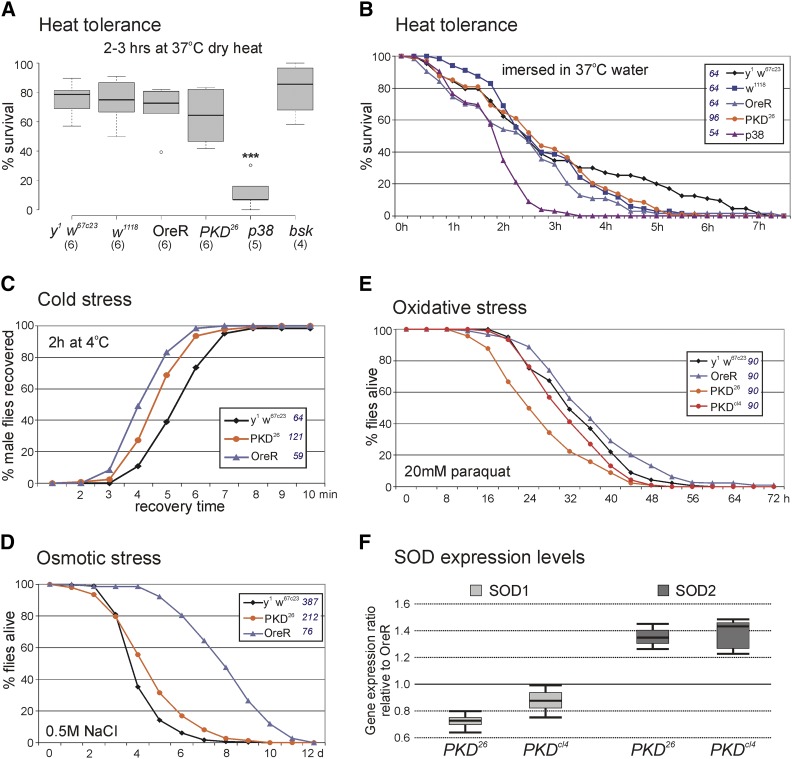
Stress resistance. Flies of the given genotype were subjected to several different stressors, exposure to dry heat (A) or wet heat (B), to cold (C), to high NaCl content for osmotic stress (D), and to oxidative stress by paraquat exposure (E). Percent of flies surviving the treatment was determined in (A) and over time in (B, D, E), respectively, whereas in (C) recovery time from treatment was measured. (A) BoxPlot representation of survivors of heat treatment is shown. Center lines show the medians; box limits indicate the 25th and 75th percentiles; whiskers extend 1.5 times the interquartile range; dots represent outliers. Numbers in parentheses indicate experiments with each approximately 30 flies. Statistical analysis was performed with a two-tailed ANOVA test relative to y1 w67c23 using Dunnet’s approach with P < 0.001, ***. (B-E) Total number of animals tested for each genotype is given in the legend. (F) Expression levels of Cu/ZnSOD (SOD1) and of MnSOD (SOD2) were quantified by qRT-PCR in the PKD mutants relative to OreR control. Data were assembled from three biological and two technical replicates. Mini-max depicts 95% confidence, median corresponds to expression ratio. Tub56D and Tbp were used as reference genes. Amplification efficiencies for SOD1 (0.92), SOD2 (0.98), for Tub56D (0.97) and Tbp (0.96) were accounted for in determining relative quantities by REST (Pfaffl et al. 2002).